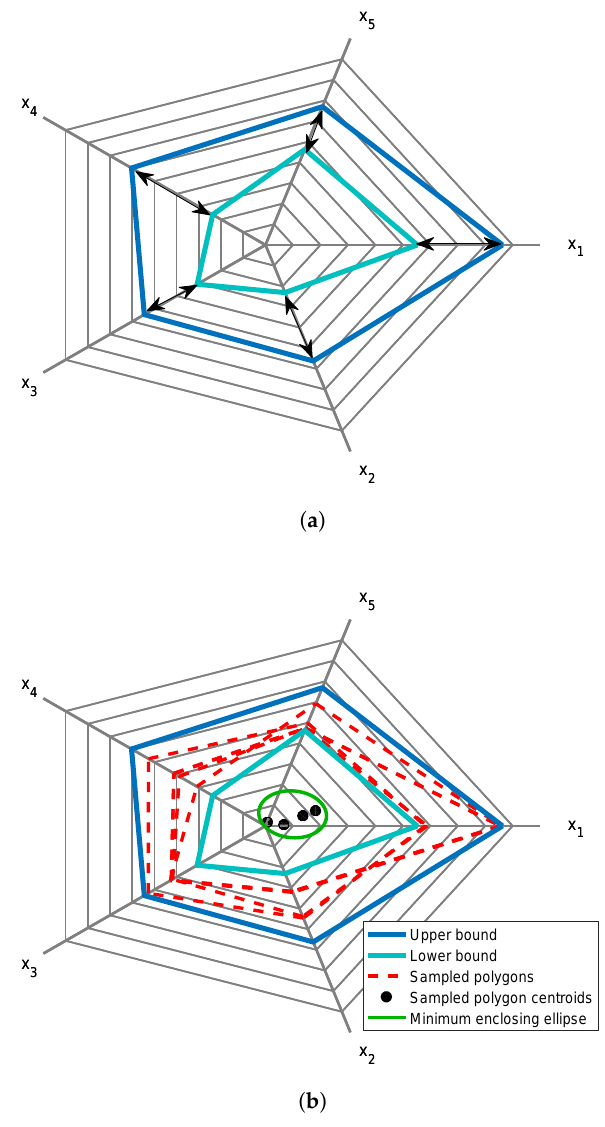
Figure 5. ( a ) Limits in time-resolved Kiviat diagram. Black arrows indicate limits for each variable. Blue and green lines are the extrema of the confidence ellipsoid. ( b ) Sampled points within the annular region (in red) are used to generate the confidence